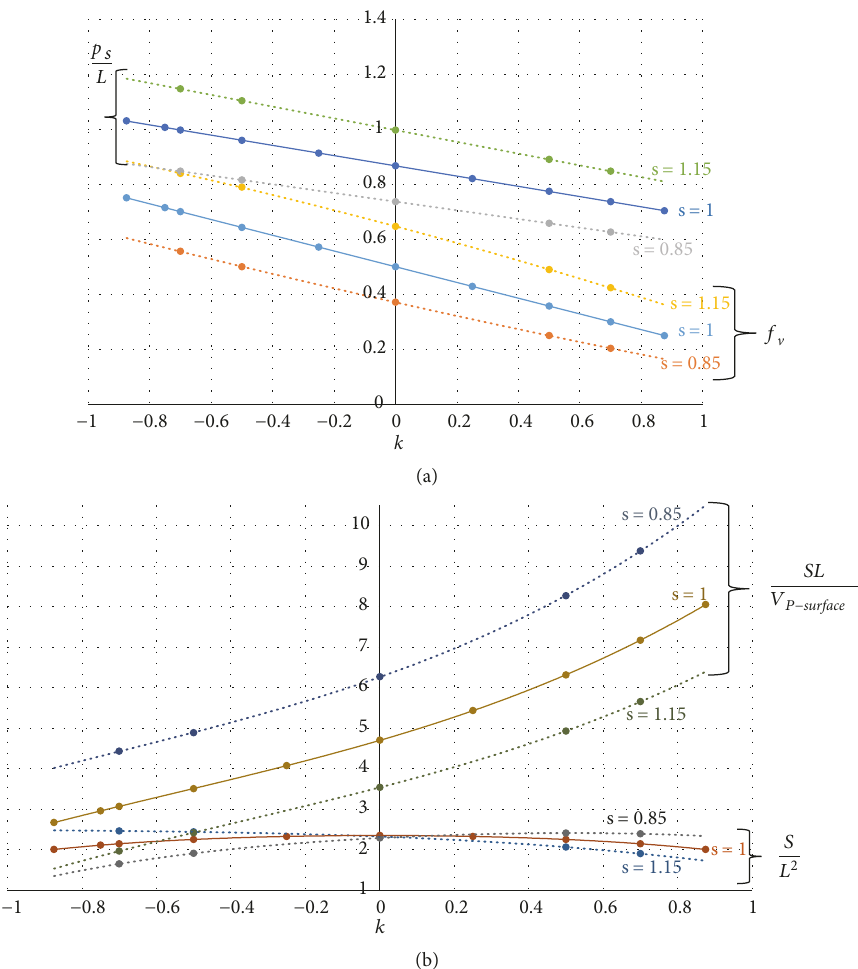
Figure 8: (a) Trend of volume fraction 𝑓 V and pore size 𝑝 𝑠 /𝐿 with varying 𝑘 and for some s values. (b) Trend of area-volume ratio and surface ratio with varying 𝑘 and for some s values.